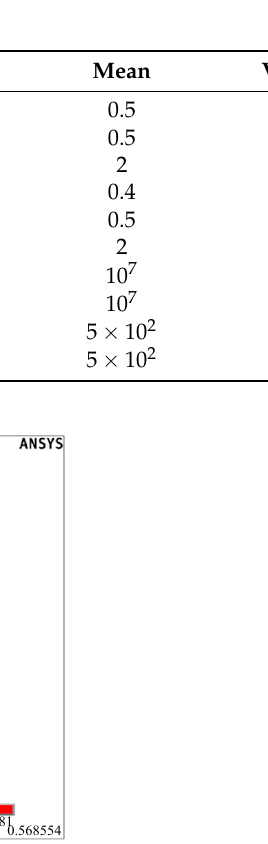
Fig.13 Deformation distribution of the 25-bar space truss structure Figure 13. Deformation distribution of the 25-bar space truss